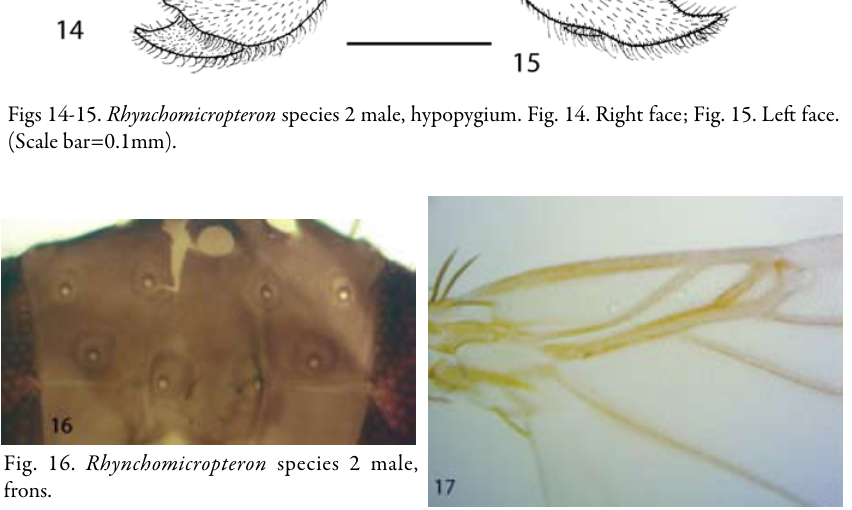
Fig. 17. Rhynchomicropteron species 3 male, costal section